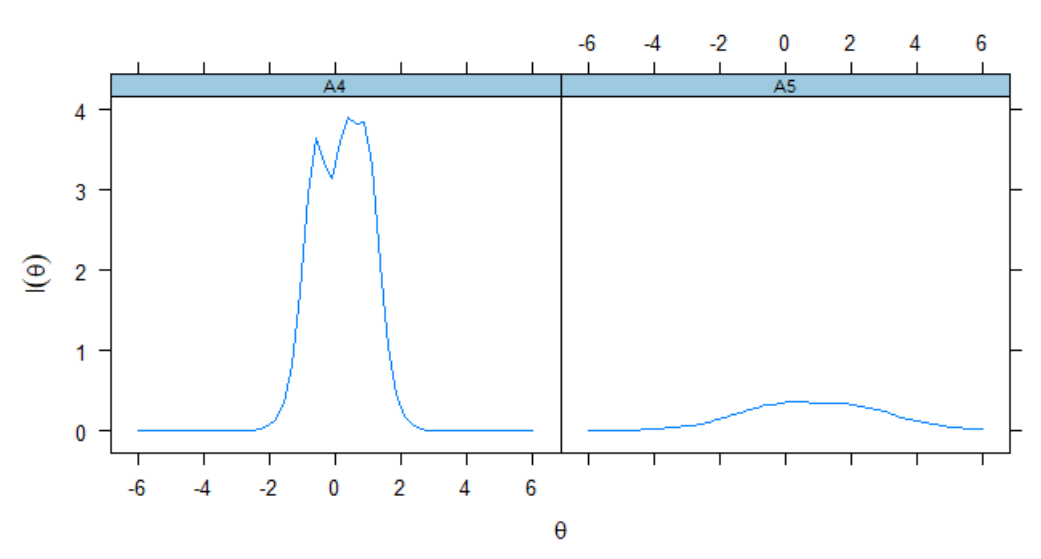
Figure 9. TICs of the Time Domain Needs component.